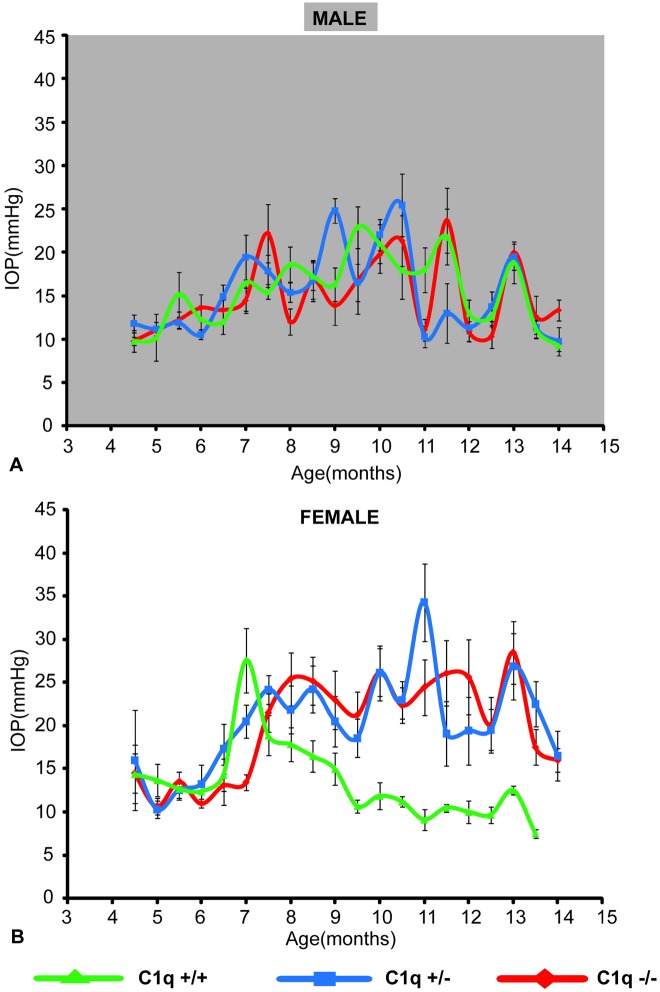
IOPs of a subset (see Table 1) of male (A) and female (B) mice used in this study.Average IOP of male mice was not significantly different between the 3 genotypes (p>0.09, ANCOVA). In contrast, female C1qa -/- and C1qa +/- mice had higher IOPs than their C1qa +/+ littermates (p<0.000001, ANCOVA). Error bars represent standard errors of mean at each age.